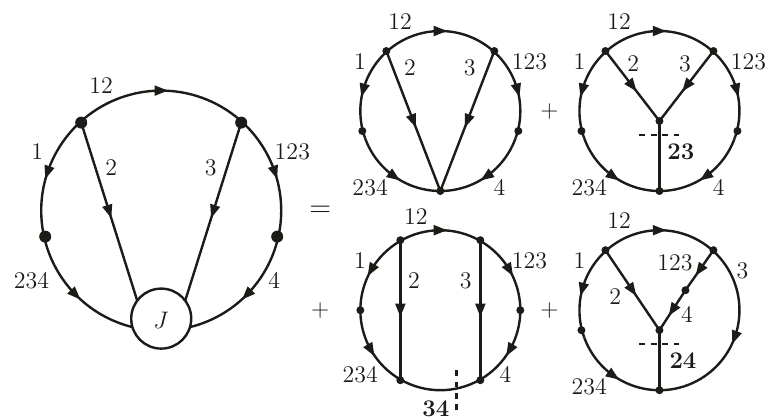
(1 ∪ 234 , 2 , 3 , 4 ∪ N 2 MLT